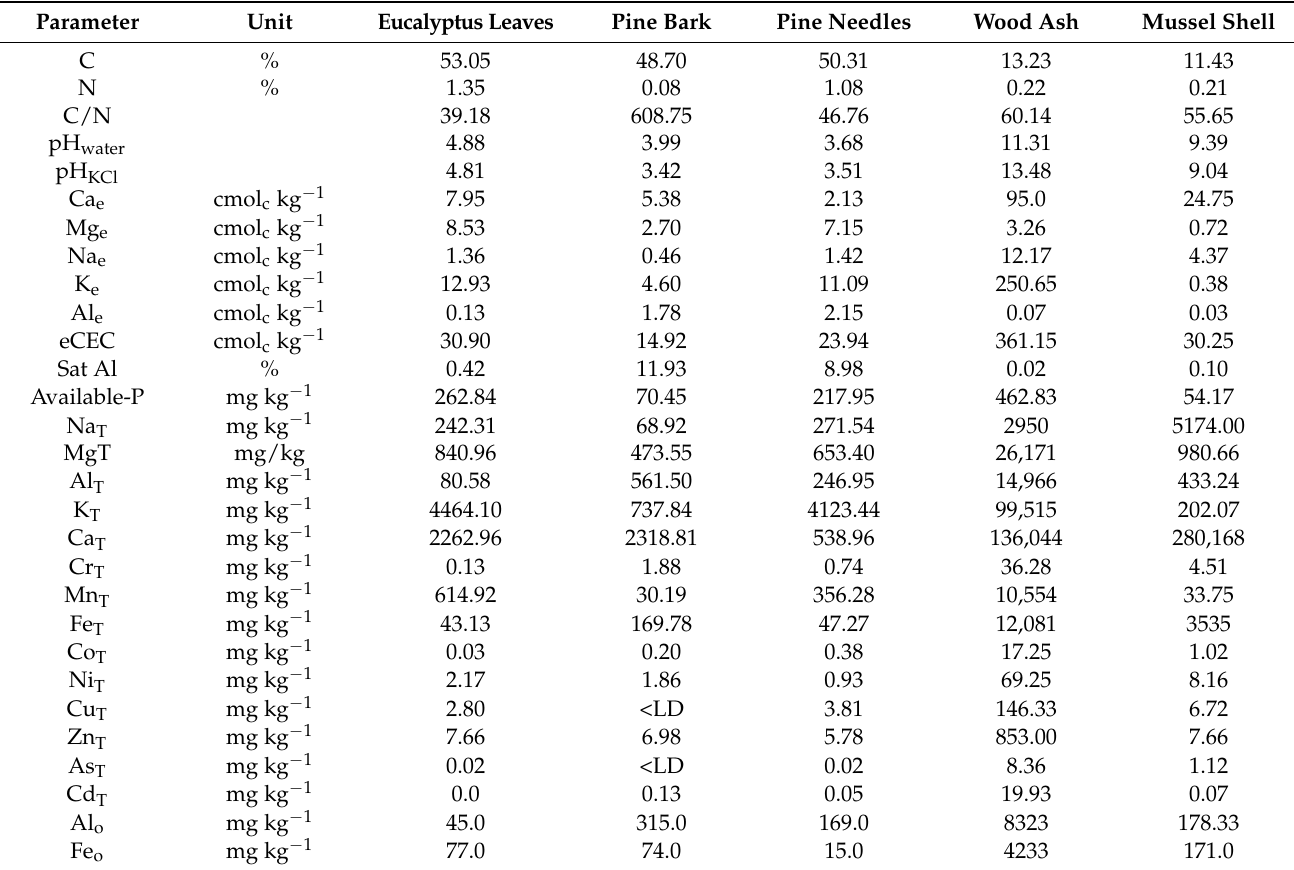
Table 1. Characteristics of the bio-adsorbent materials. C: total carbon; N: total nitrogen; Ca e , Mg e , Na c , K e, Al e : elements in the exchange complex; Sat. Al: Al-saturation in the exchange complex; eCEC: effective cation exchange capacity; X T : total content of the element (X); Al o , Fe o : noncrystalline Al and Fe. Average values (n = 3), with coefficients of variation always